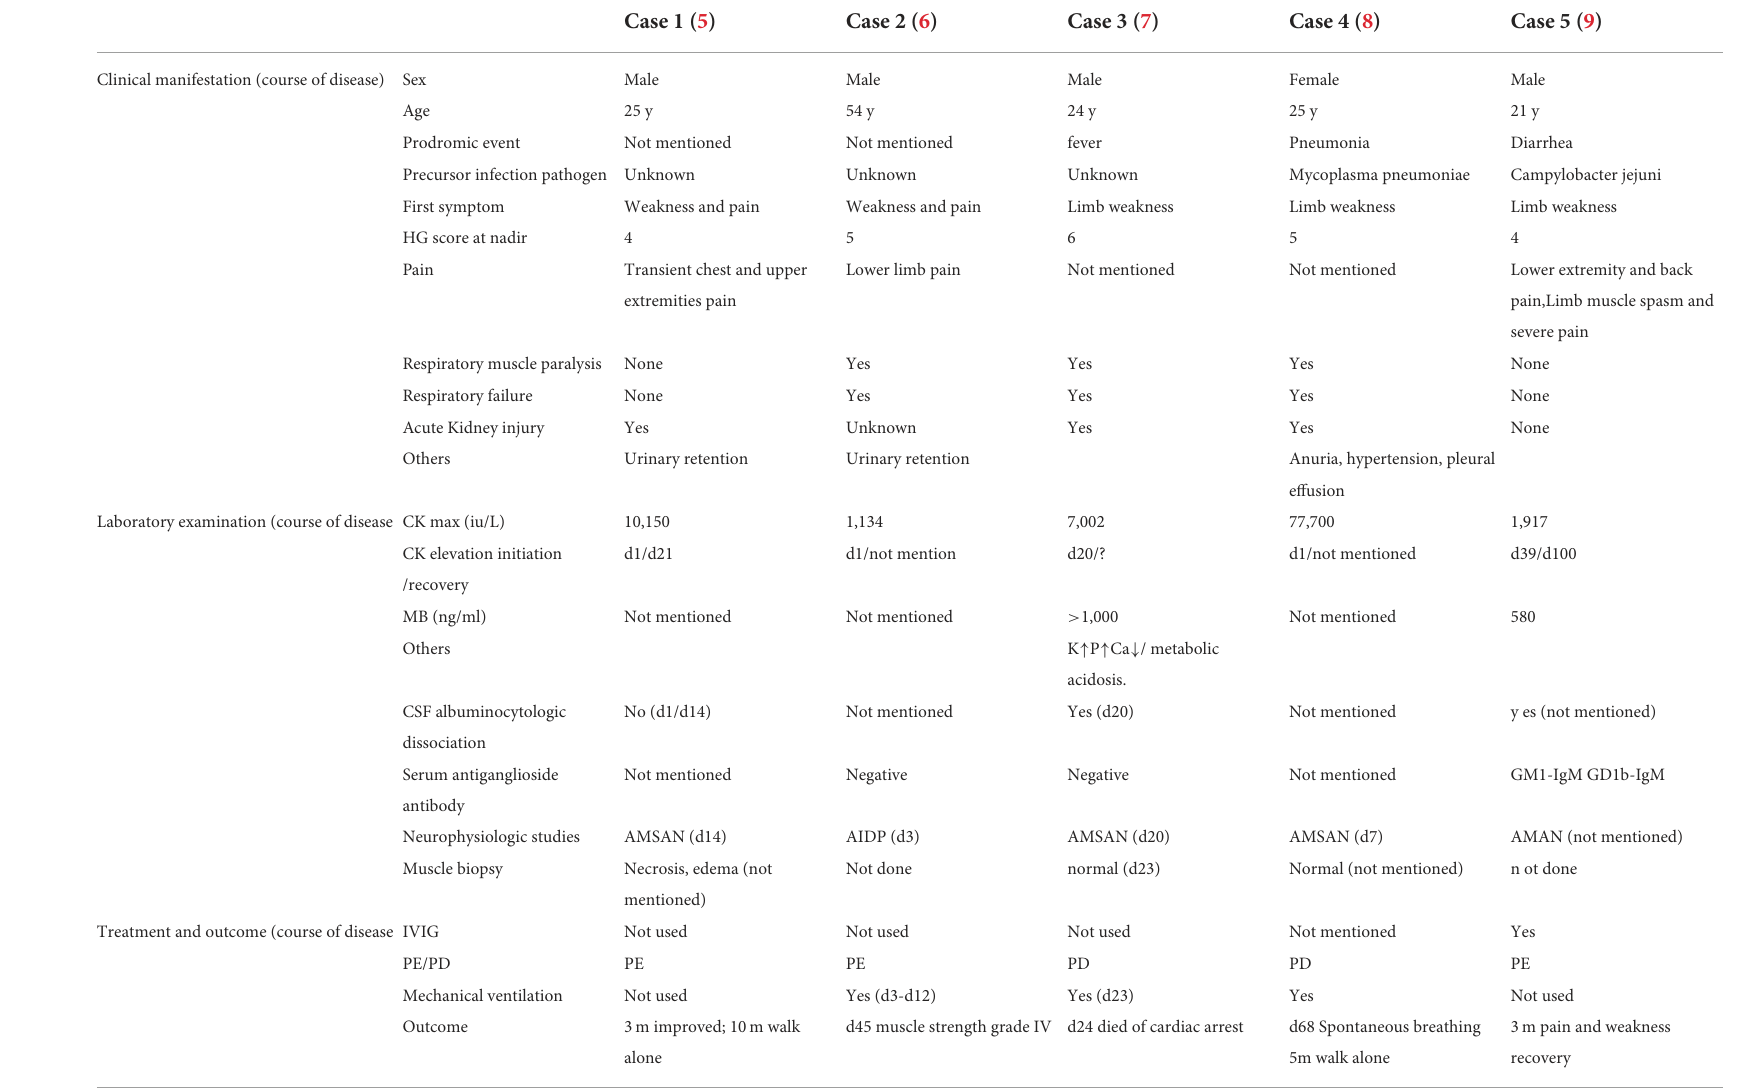
TABLE 2 Literature review and patient